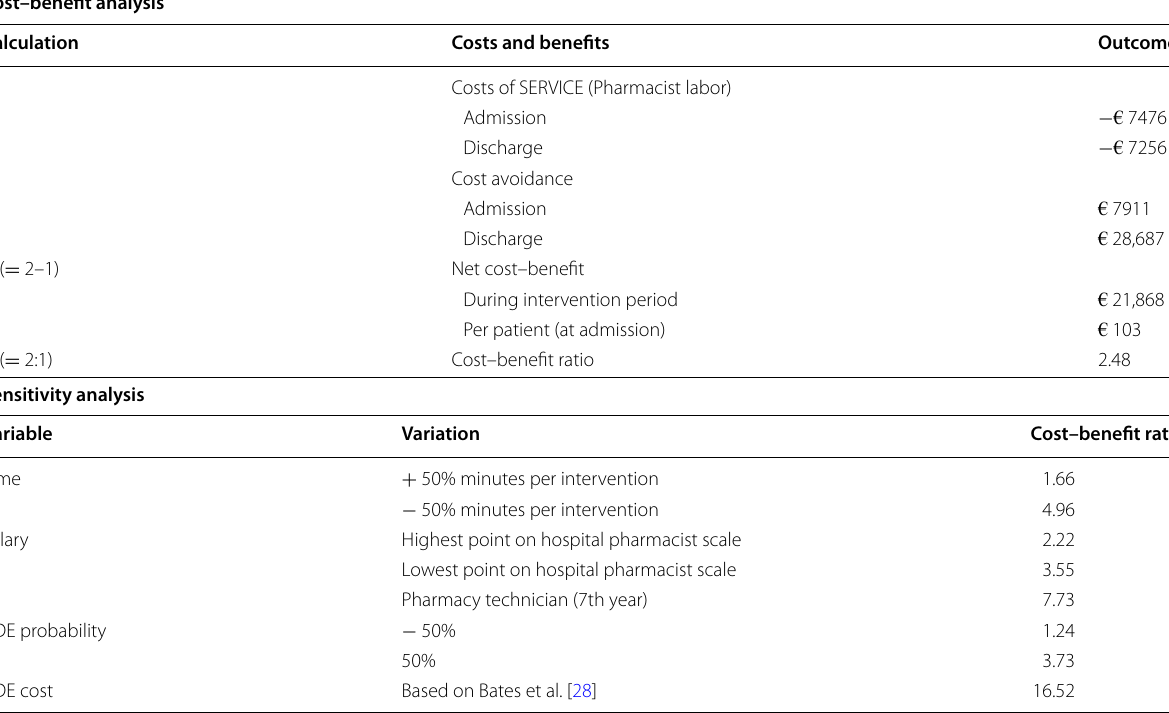
ADE adverse drug event a Based on 2014 Euro cost